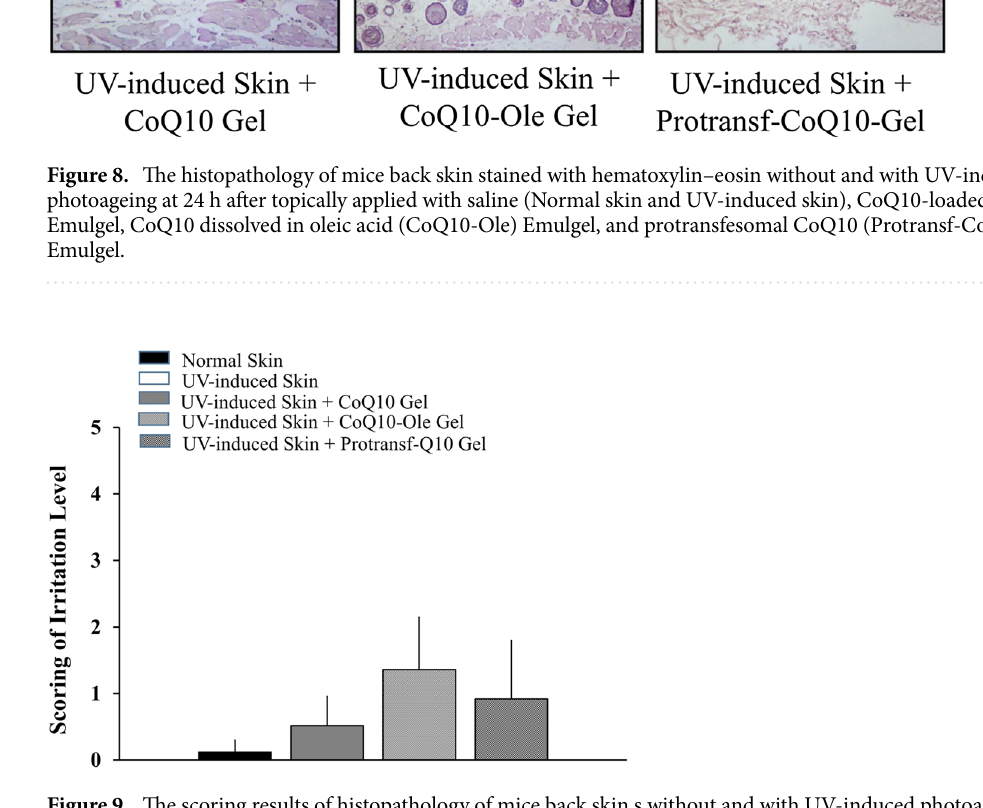
Figure 9. The scoring results of histopathology of mice back skin s without and with UV-induced photoageing at 24 h after topically applied with saline (Normal skin and UV-induced skin), CoQ10-loaded Emulgel, CoQ10 dissolved in oleic acid (CoQ10-Ole) Emulgel, and protransfesomal CoQ10 (Protransf-CoQ10)